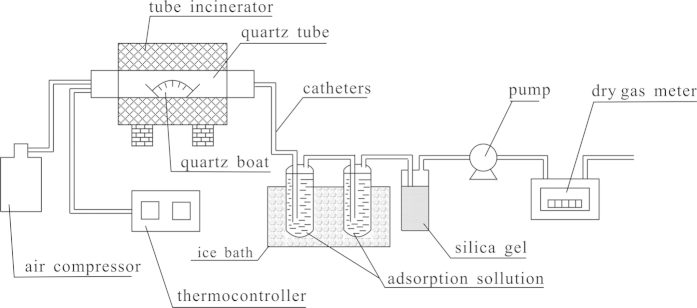
Experimental apparatus of quartz tube simulation combustion reactor.